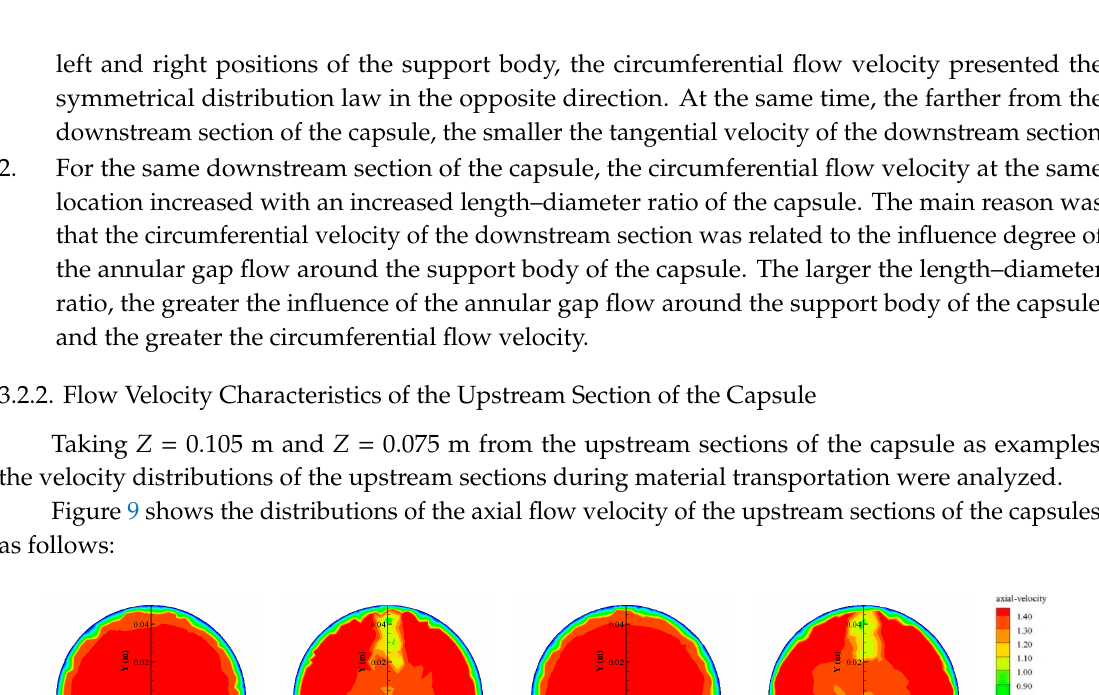
Figure 8. Circumferential velocity distributions of the downstream sections of capsules. ( a ) Z = 0.225 m, L/D = 2; ( b ) Z = 0.075 m, L/D = 2; ( c ) Z = 0.225 m, L/D = 1.67; ( d ) Z = 0.075 m, L/D = 1.67.